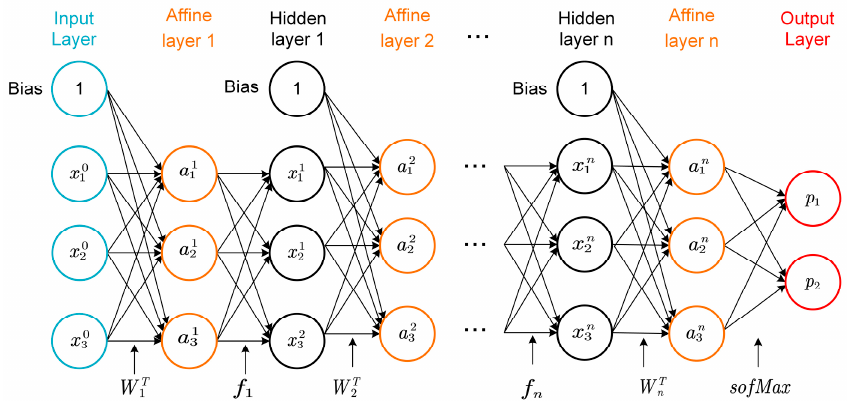
Figure 4. Schematic diagram of multilayer perceptron.